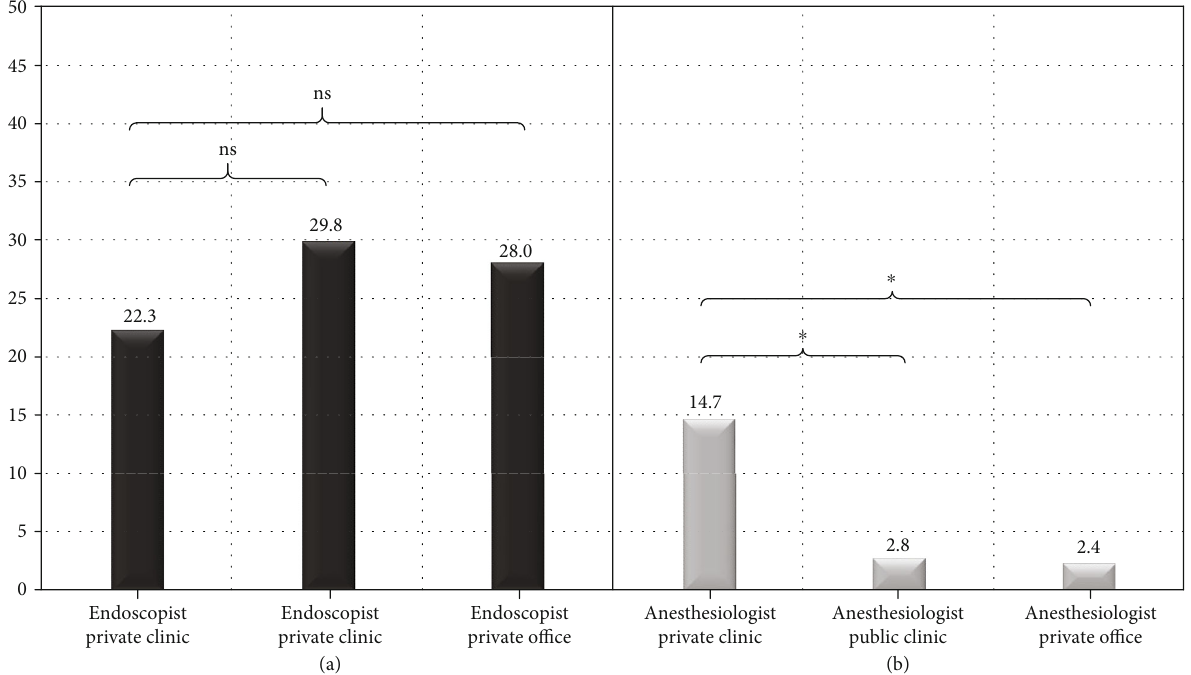
Figure 4: Sedation administration of (a) endoscopist and (b) anesthesiologist, by setting (clinic in private hospital, clinic in public hospital, and private o ffi ce). ns: not signi fi cant; ∗ p < 0 : 05